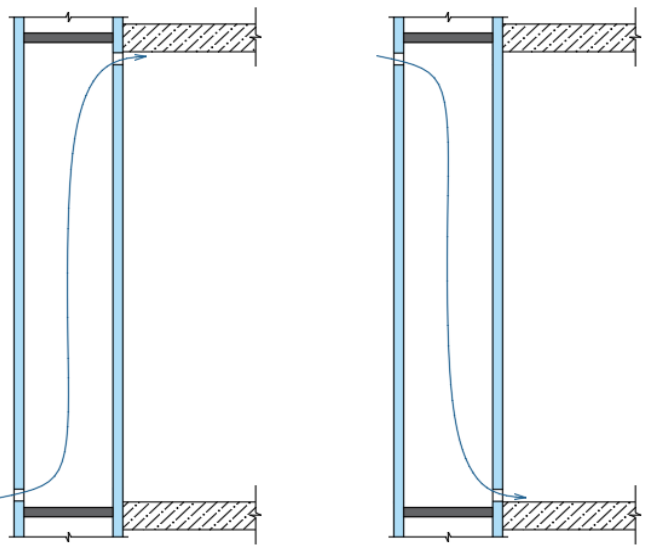
Figure 11. Facade systems with air mode.